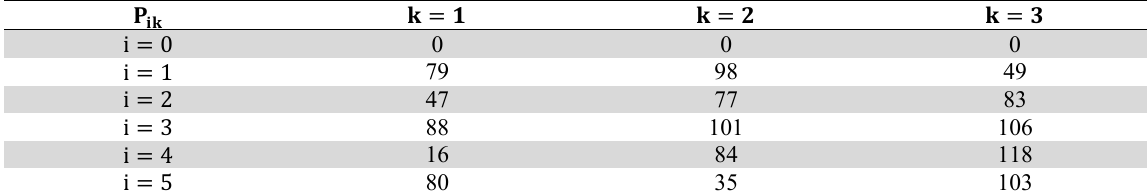
Processing times for the presented example